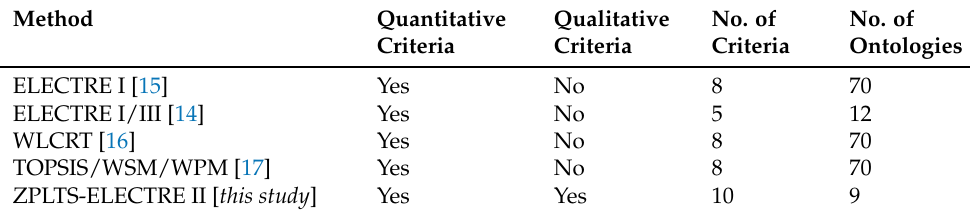
Table 29. Comparison of ZPLTS-ELECTRE II with other MCDM methods for ontology ranking.